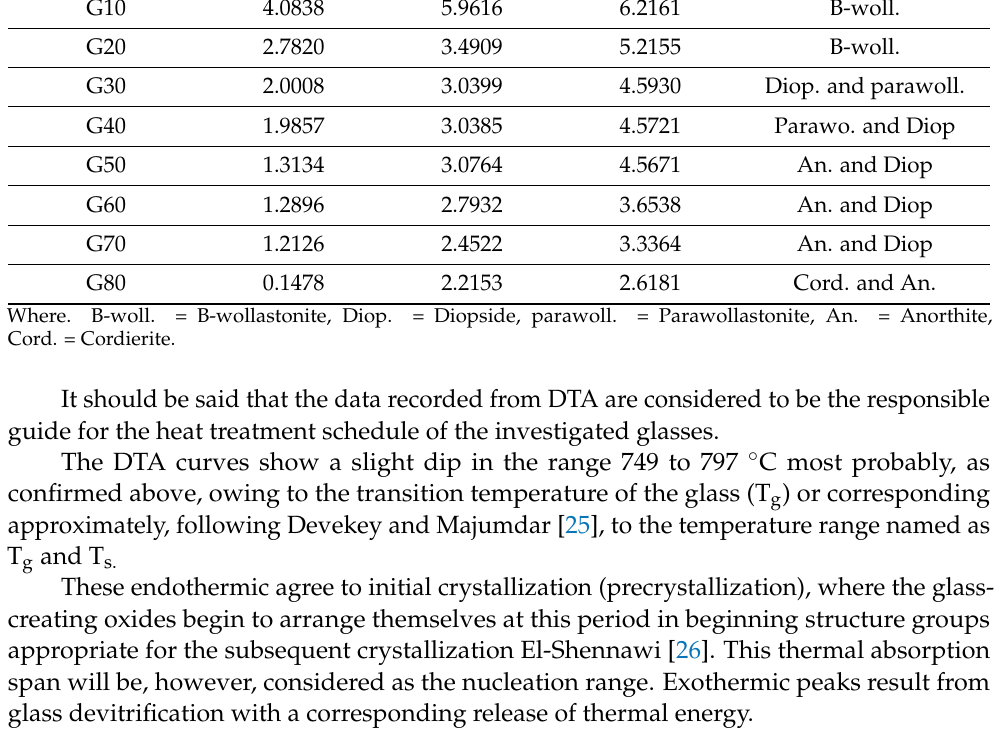
Table 3. Thermal expansion coefficient and phases developed of the investigated samples. Glass